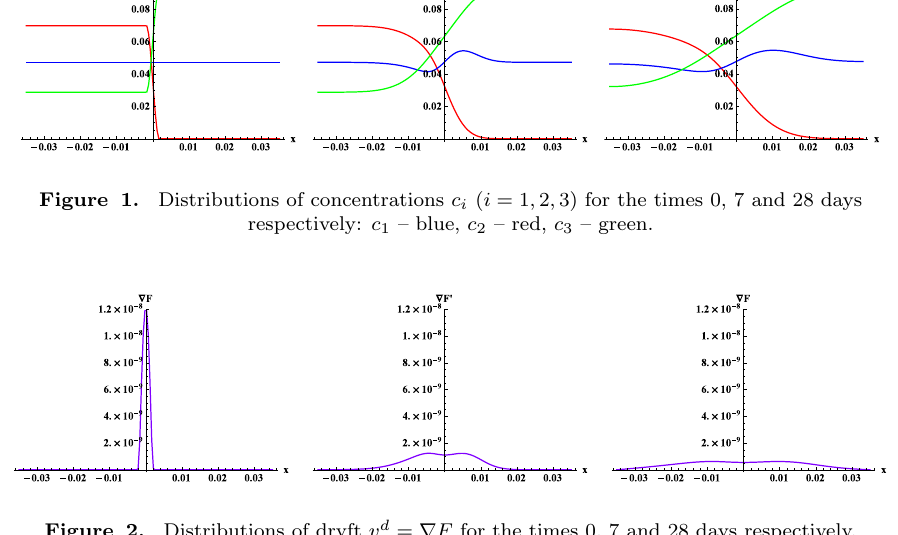
Figure 2. Distributions of dryft v d = ∇ F for the times 0, 7 and 28 days